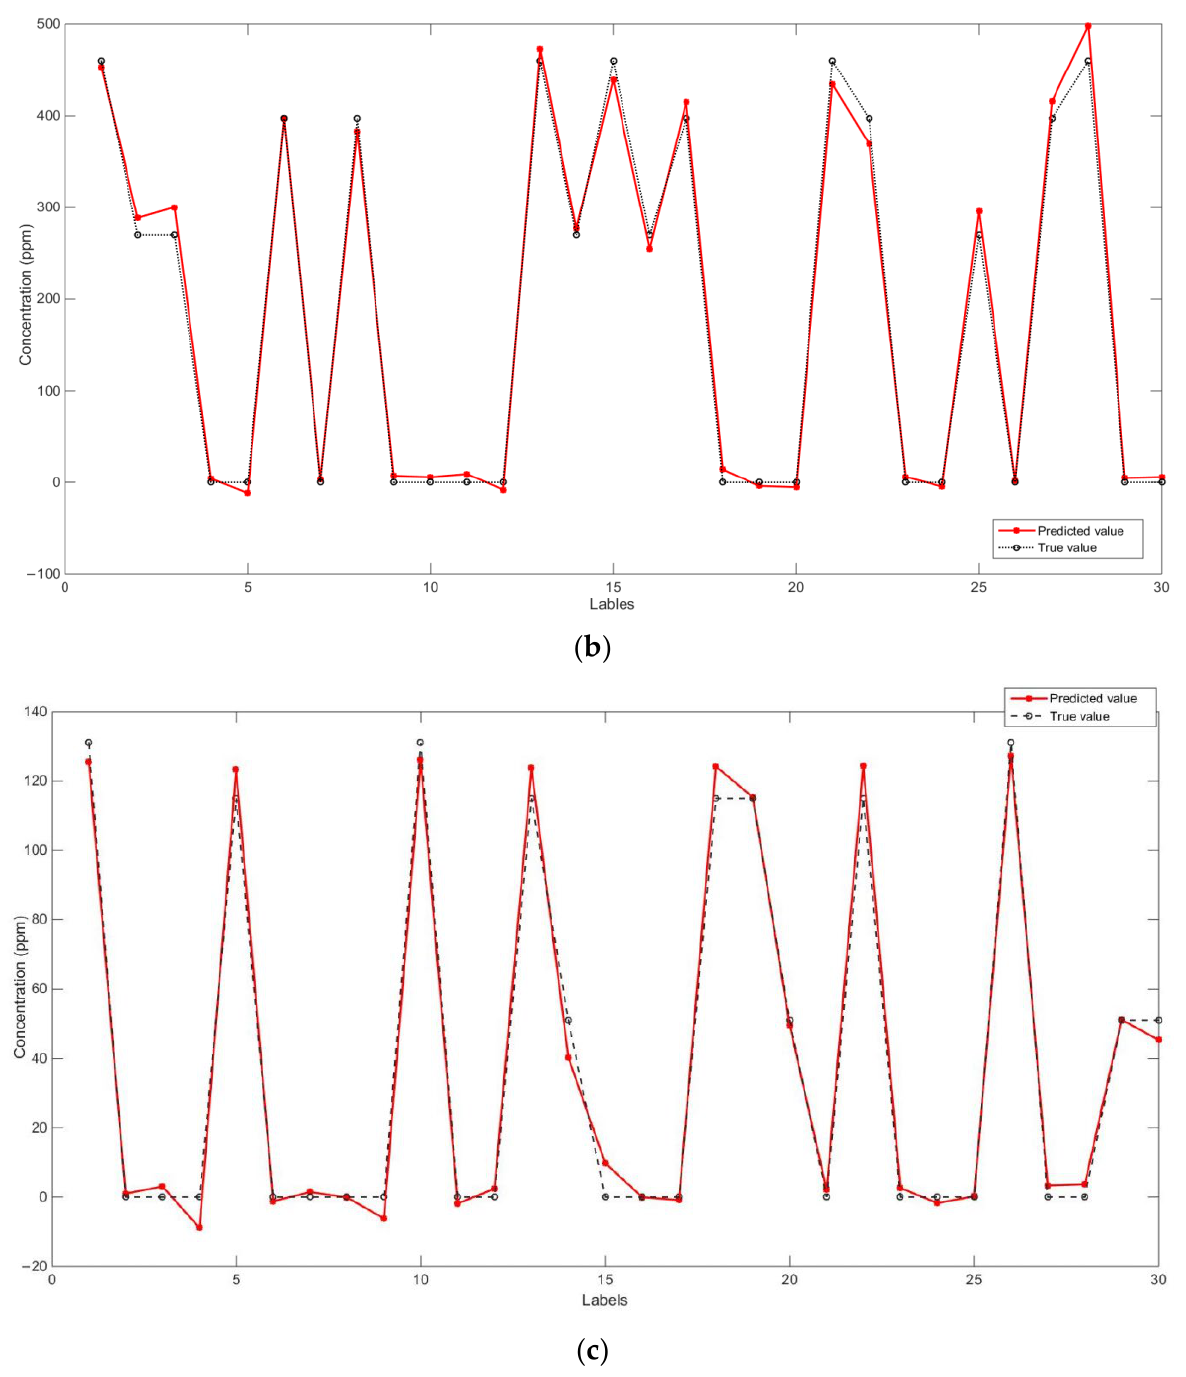
Figure 14. Prediction results for three gas concentrations under the full-sample selection strategy. ( a ) Comparison of predicted and real ethylene concentration; ( b ) comparison of predicted and true values of carbon monoxide concentration; ( c ) comparison of predicted and true methane concentra- tions. Table 13. Prediction results for three gas concentrations with the full-sample selection strategy.